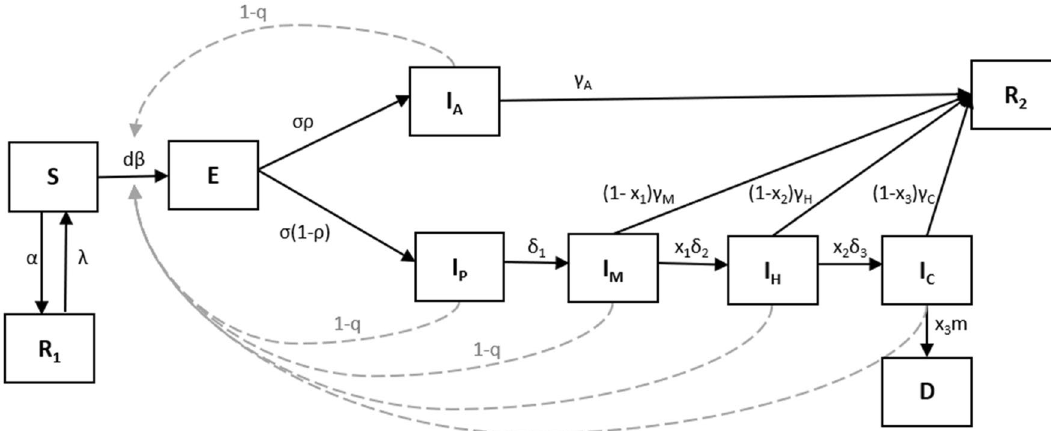
Figure 8. Compartmental model structure. Boxes or compartments represent host categories related to infection status, solid lines represent movement between compartments, and dashed arrows depict the states contributing to transmission. Full details of model structure and the full set of differential equations and parameters driving the model are given in Supplementary Table